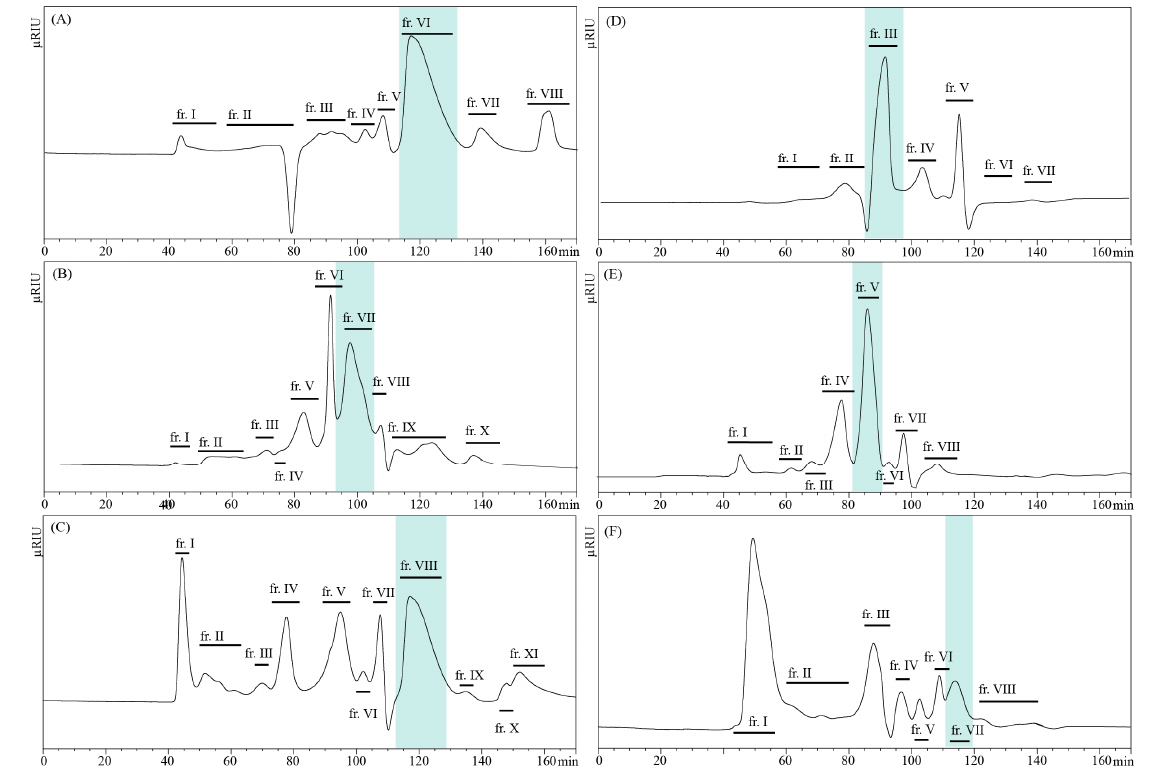
Figure 2. Gel-filtration chromatography profiles of the heteropolysaccharides isolated from LPS of the Bordetellae and separated on the Superdex 30 pg, with RI detector. ( A ) B. pertussis 606, ( B ) B. pertussis 186, ( C ) B. holmesii ATCC 51541, ( D ) B. bronchiseptica 530, ( E ) B. bronchiseptica 1943, and ( F ) B. parapertussis 529. The marked regions represent the main fractions used for the structural analysis.